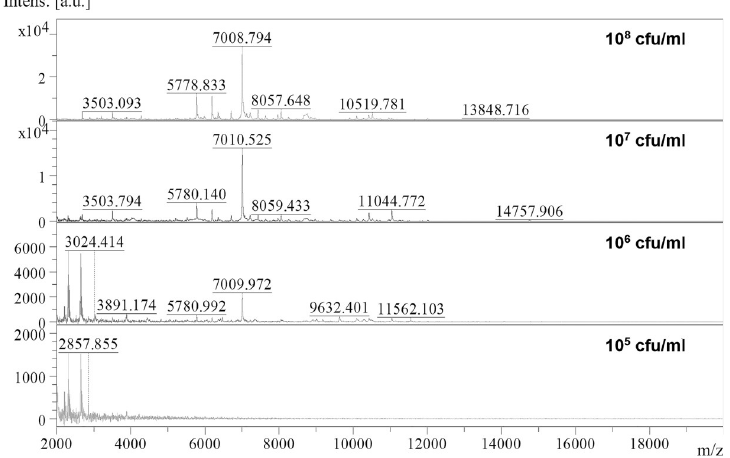
Fig 3. The protein mass spectra of L . interrogans at different bacterial concentration. X-axis represent Spectra at mass to charge ratio of 2000–20000, Y axis is peak intensity at arbitrary unit (a.u.).